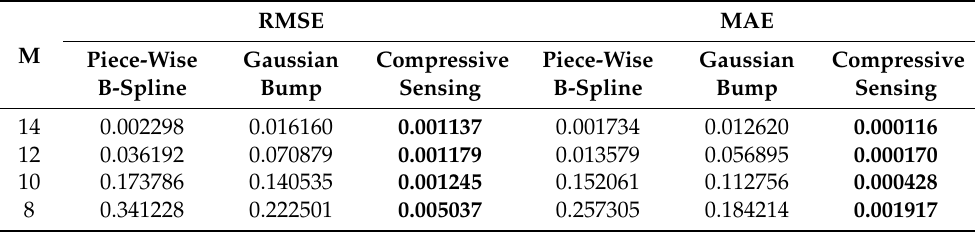
Table 2. The recovery error of the Triple-peak Spectrum with three spectrum-unfolding methods.